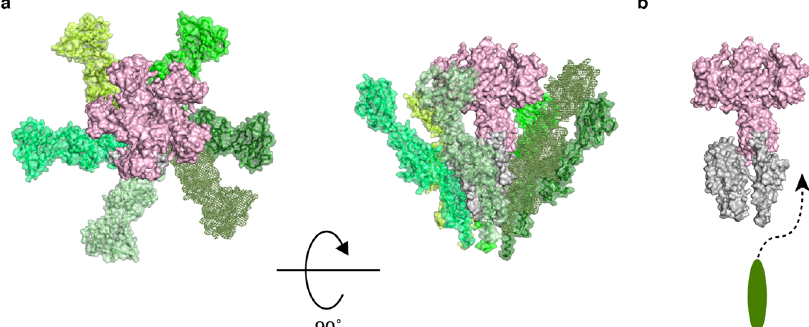
Fig. 6 A model of hook assembly by the hook cap. a The pentamer hook cap (light pink) and ten FlgE subunits of the hook ( fi ve different greenish colors and gray) are shown in solid surface representation viewed from the top and side. Only domain D0 of FlgE is shown in gray for the fi rst fi ve subunits from the distal end of the hook. The next fi ve FlgE subunits are shown in green, lime, smudge, limon, and pale green. b The fi ve subunits in the greenish colors are removed from the right panel of a and a newly exported FlgE molecule is added as an elongated ellipse. The N-terminal part of FlgD missing in the model of the hook cap might occupy the space for domain D0 of the FlgE molecule to be